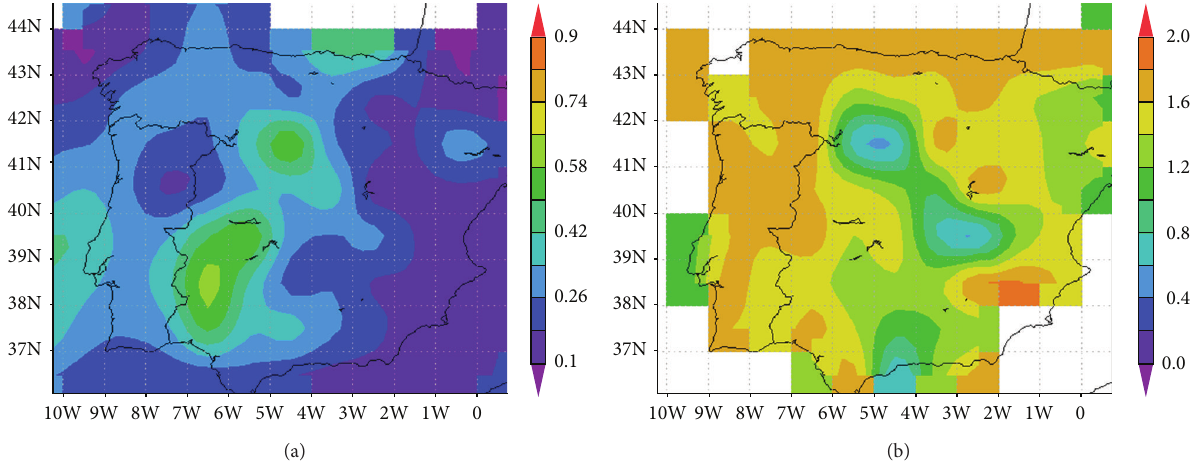
Figure 2: (a) Terra-Modis aerosol optical depth at 550 nm and (b) Terra-Modis ˚Angstr¨om exponent (470/660 nm) on 18 October 2011. Terra-MODIS products for that day, depicted in Figure 2, show high values of both the aerosol optical depth (at 550 nm) and the ˚Angstr¨om exponent (440/670 nm wavelength pair), which was higher than 1.6, over large portions of the Iberian Peninsula, including the region over ´Evora. The